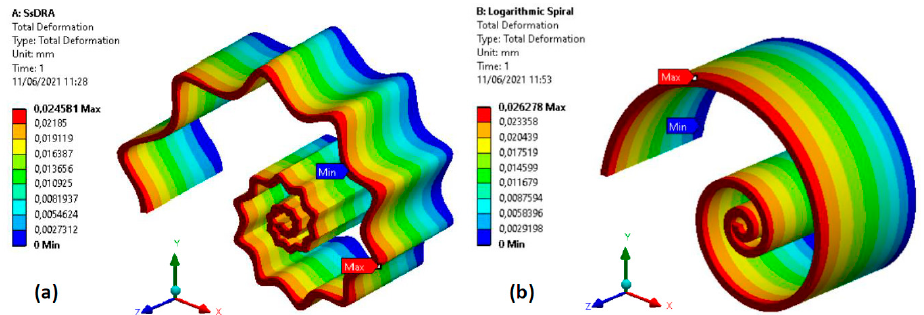
Figure A4. A comparison of the flexural stiffnesses of the SsDRA and LsDRA in cantilever configu- ration: ( a ) and ( b ) deformations under a load corresponding to Fx = 200 N; Fy = Fz = 0; ( c ) and ( d ) deformations under a load corresponding to Fy = − 200 N; Fx = Fz = 0.